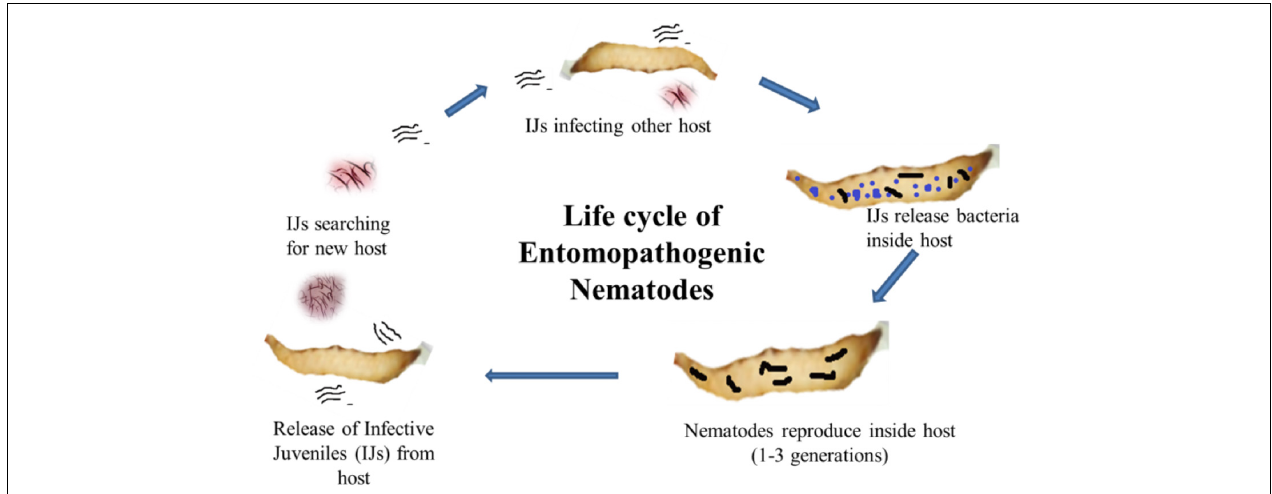
FIGURE 1 | Life cycle of entomopathogenic nematodes showing infective juveniles (IJs) enter into the host body and release symbiotic bacteria from the gut to kill the host. The nematode reproduces inside the dead cadaver, and IJs are released into the soil in search of a new